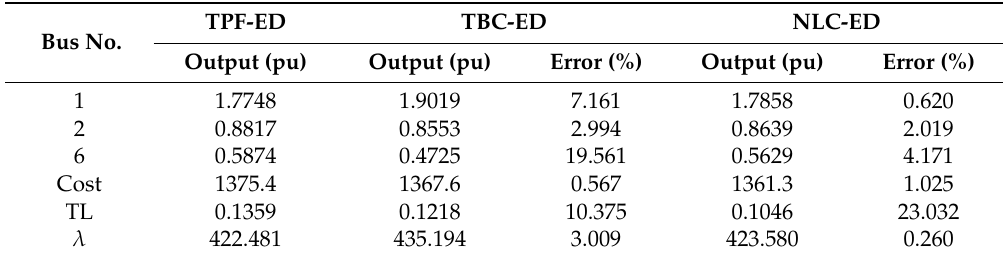
Table 4. ED simulation results compared with traditional ED and new loss coefficients of the IEEE 14-bus system under the conforming system demand increased by 20% condition.